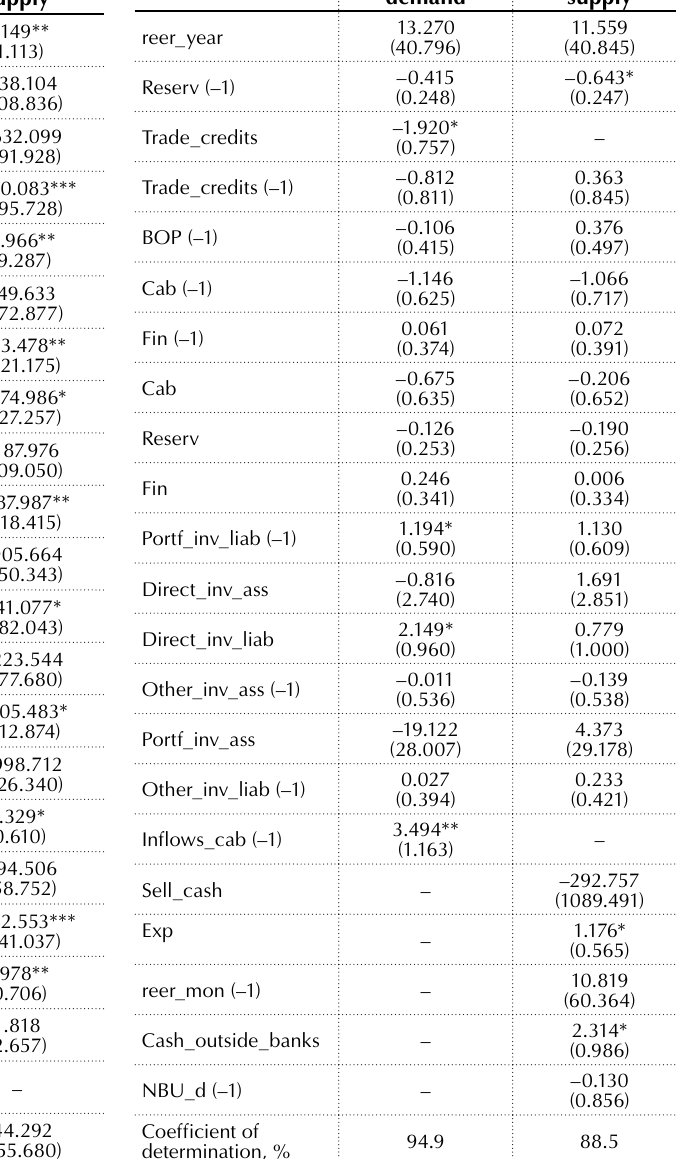
Source : calculated by